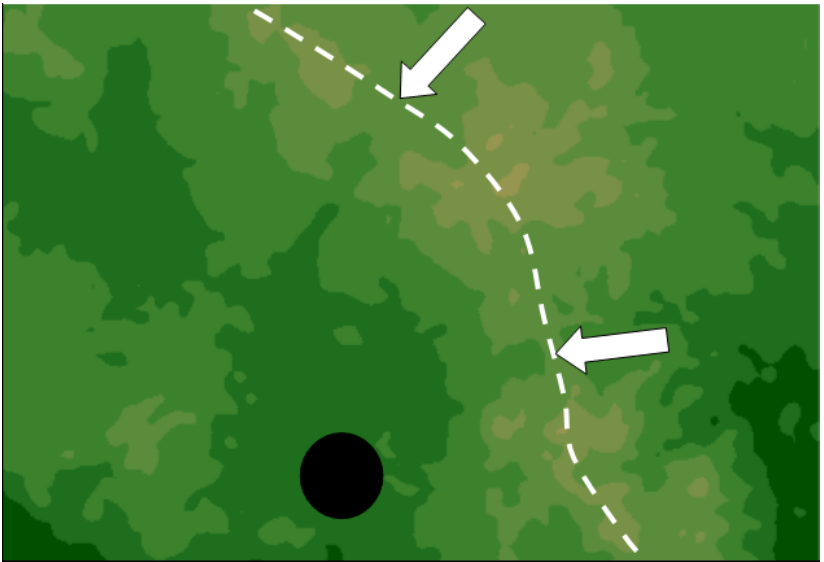
Figure 8. The 40 × 60 km area enclosed by the orange box in Figure 7. Shaded elevation data produced by the gust front model. The mountain range is identified by a dashed line with lower elevation gaps identified by arrows. Radar-observed smoke plume of the Yarnell Hill fire shown by the black circle.